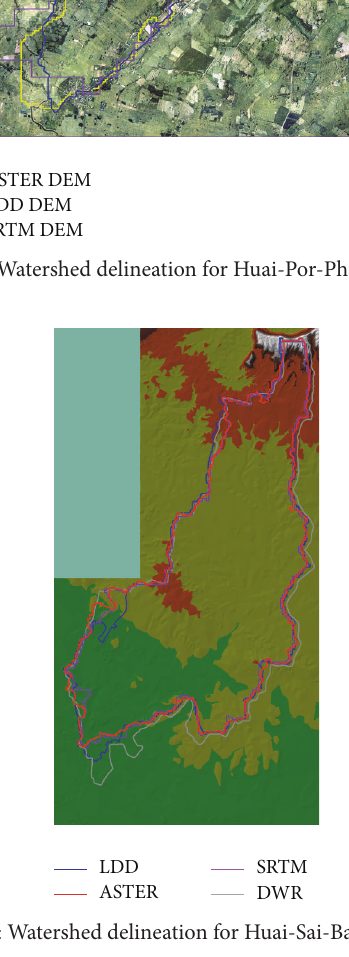
Table 5: Size of area extracted from DEMs of Huai-Por-Phan watershed.